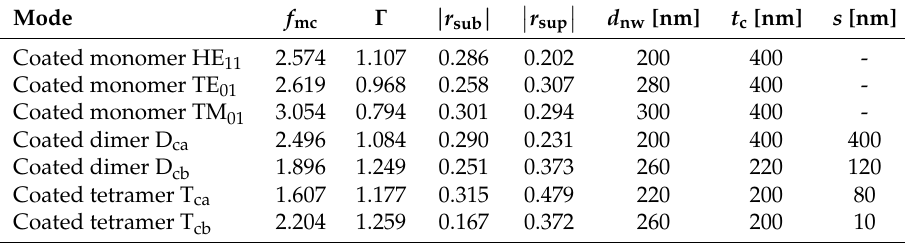
(cid:12) (cid:12) (cid:12) r sup (cid:12) ), diameters of